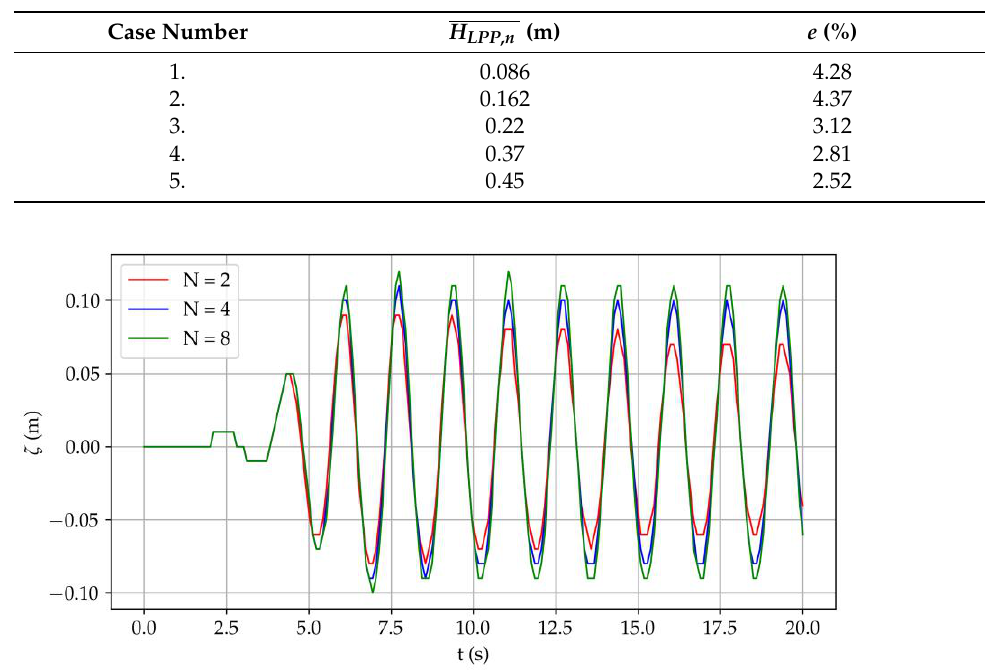
Table 5. Wave propagation errors due to spatial discretization with eight cells per wave height.